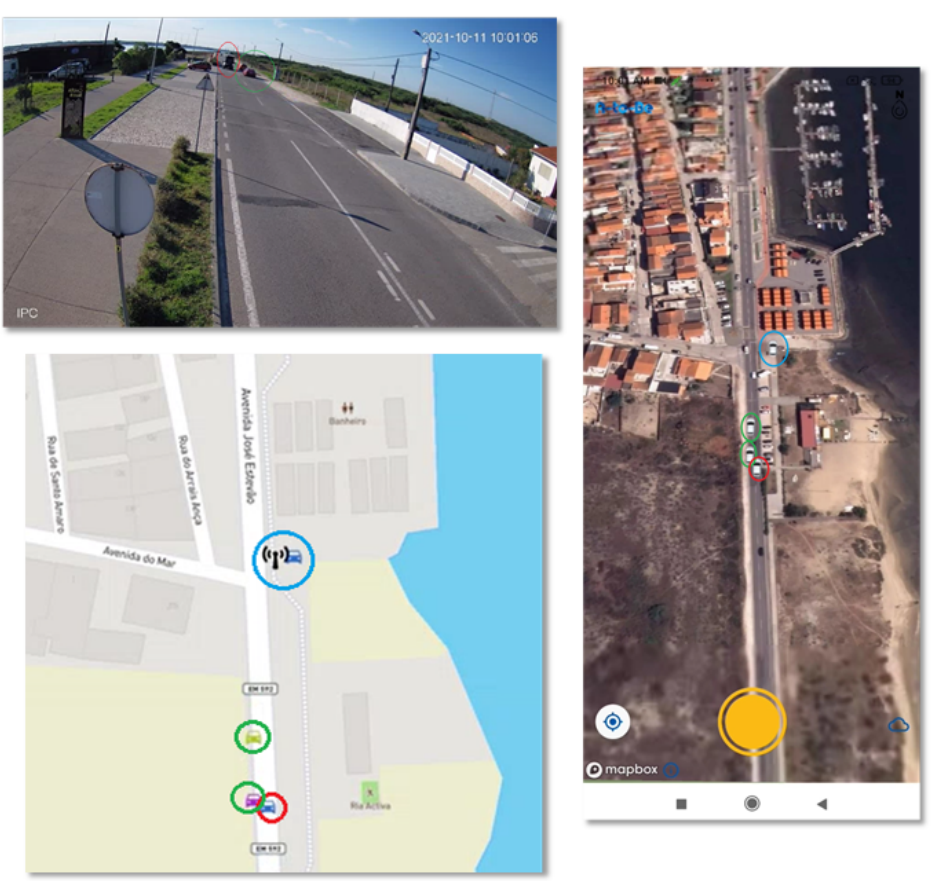
Figure 11. Visualisation of the CPMs’ information in the mobile phone and web